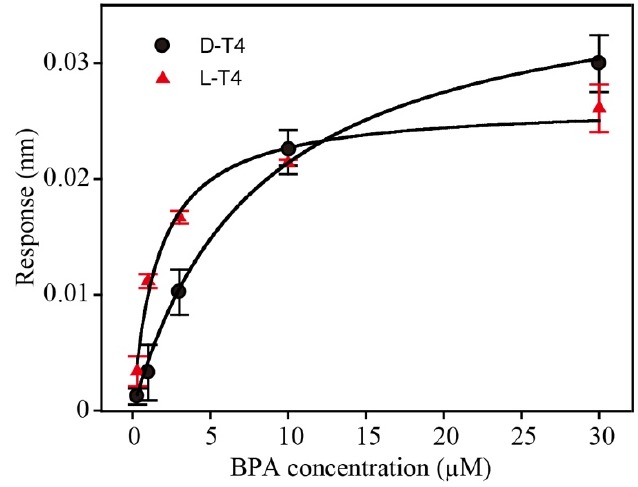
Figure 2. Dissociation constant of the BPA aptamer (D-T4) and its spiegelmer (L-T4). Biolayer interferometry was used to measure the aptamer/spiegelmer binding to BPA (n = 3). The K D values were estimated as 6.4 and 1.6 µ m for D-T4 and L-T4, respectively.